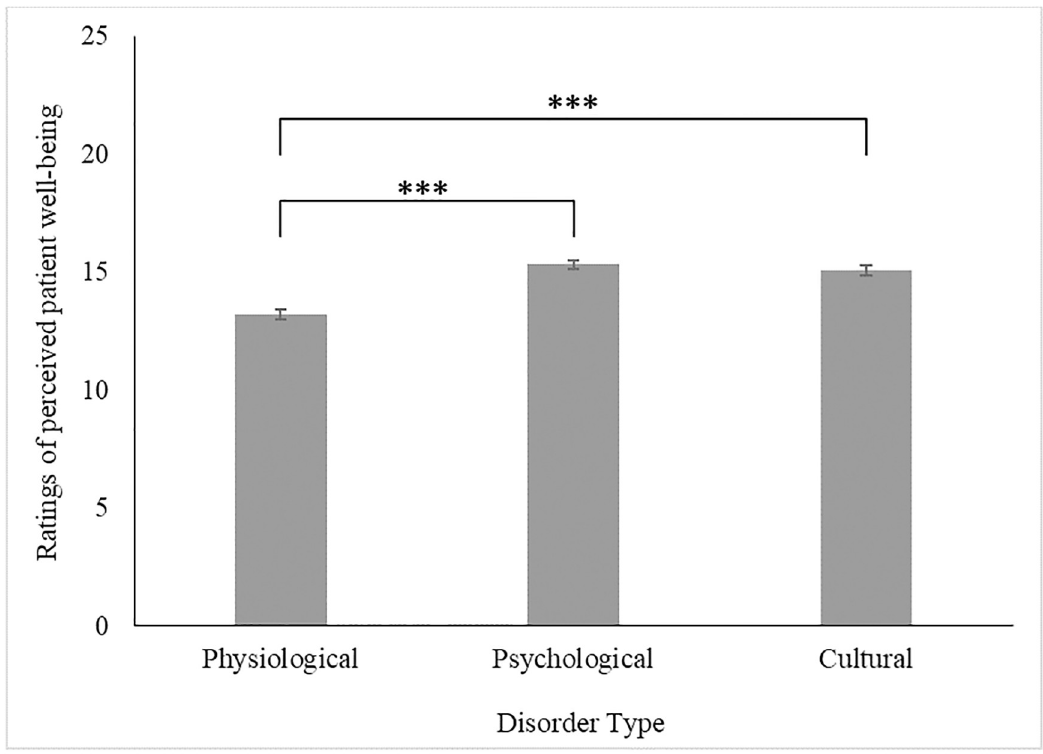
Fig 2. The effect of Disorder Type on ratings of perceived patient well-being (with SE mean ). Note : ��� p < .005; �� p < .030; � p < .050. Higher scores are indicative of greater perceived well-being of